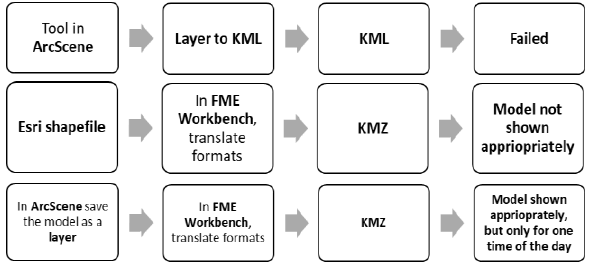
Figure 2 The zoomed in view of the western and southern sides of the noise The Air Quality Model: The air quality model shown in Figure 3 has the scale colour of navy blue through light blue to green with the darkest blue representing the poorest air quality and green representing lower levels of NO x .